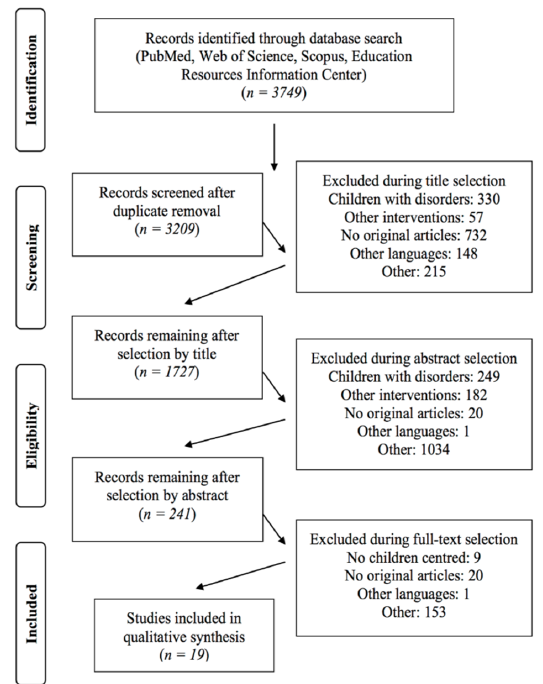
Figure 1. Flow diagram representing the selection process for manuscripts.